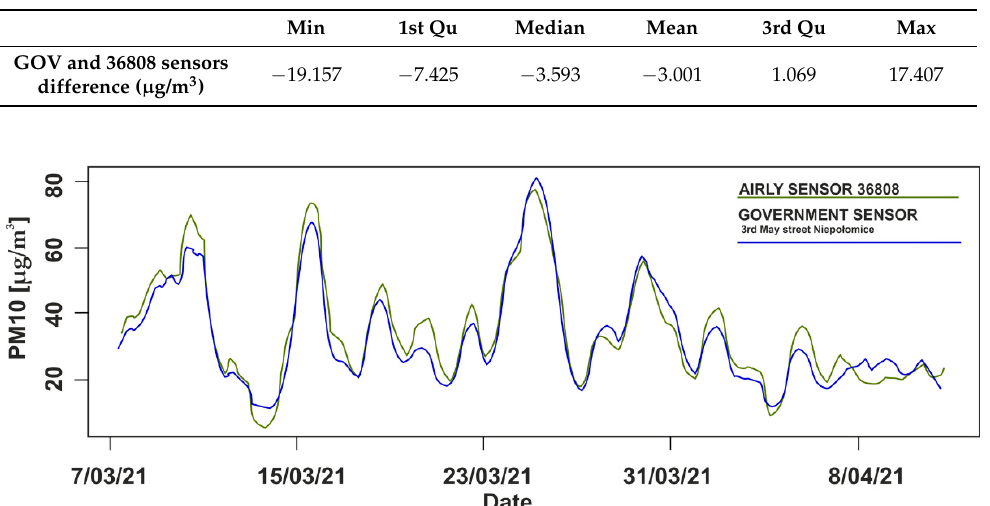
Table 3. Statistics for the difference in PM10 measurements between government station and Airly sensor 36808 for 24 ‐ hour averaged periods between 7 March and 16 April 2021.